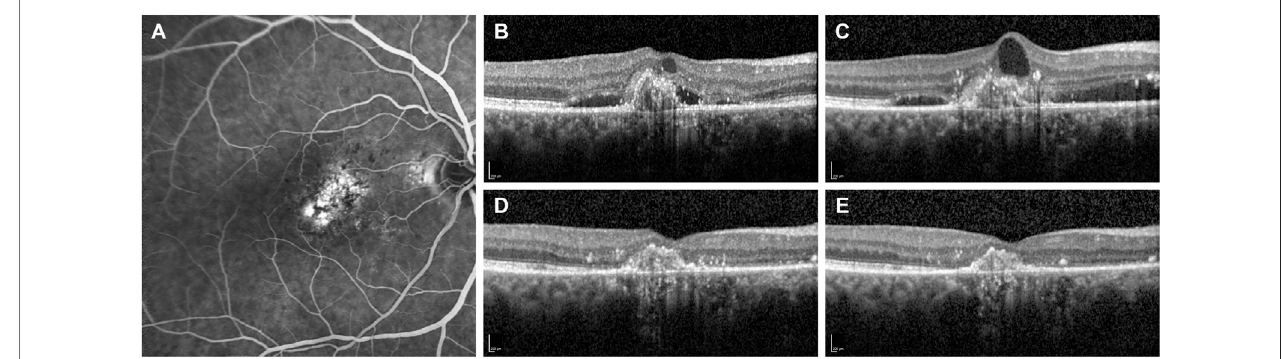
FIGURE 2 | Fluorescein angiography and optical coherence tomography (OCT) B-scans of a patient with subfoveal choroidal neovascularization secondary to neovascular age-related maculardegeneration. (A) Baseline fl uoresceinangiography demonstrates the presence ofasubfoveal type 1choroidal neovascularization. (B) OCTB-scanatthediagnosisshowsahypere fl ectivesubfoveallesionwithintra-andsub-retinalaccumulationof fl uid(IRFandSRF). (C) OCTB-scanat13-monthfollow- up after a total of eight IVT injections of ranibizumab demonstrates the persistence of IRF and SRF. Therefore, the patient was switched to monthly intravitreal brolucizumab (IVT-B). (D) OCTB-scan 1-month visitafter the fi rst IVT-B reveals thecomplete resolution ofIRF and SRF with areduction ofthe central sub fi eld thickness from 354 to 233 µm. (E) OCT B-scan at 3-month visit after the third IVT-B shows a dry retina and no recurrences are observed. Furthermore, the visual acuity improved from 20/125 to